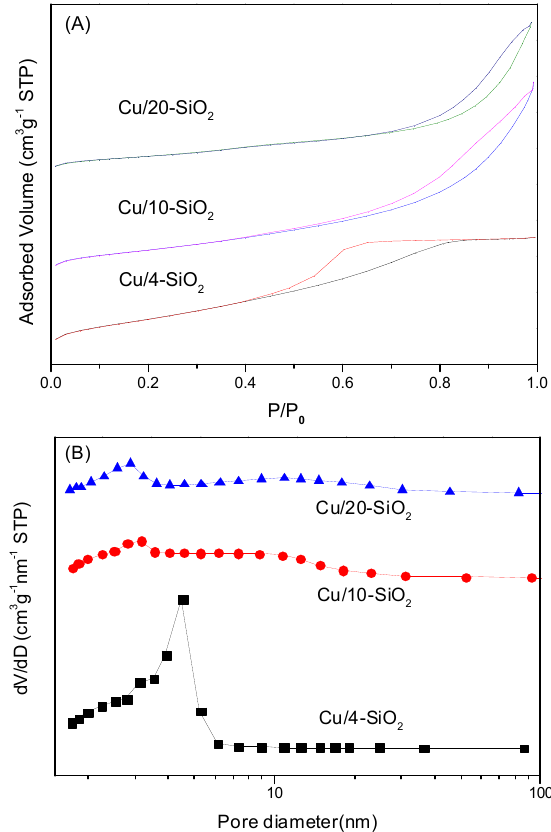
Figure 1. ( A ) N 2 adsorption–desorption isotherms, and ( B ) Brunauer–Emmett–Teller (BJH) pore size distributions of calcined catalysts.